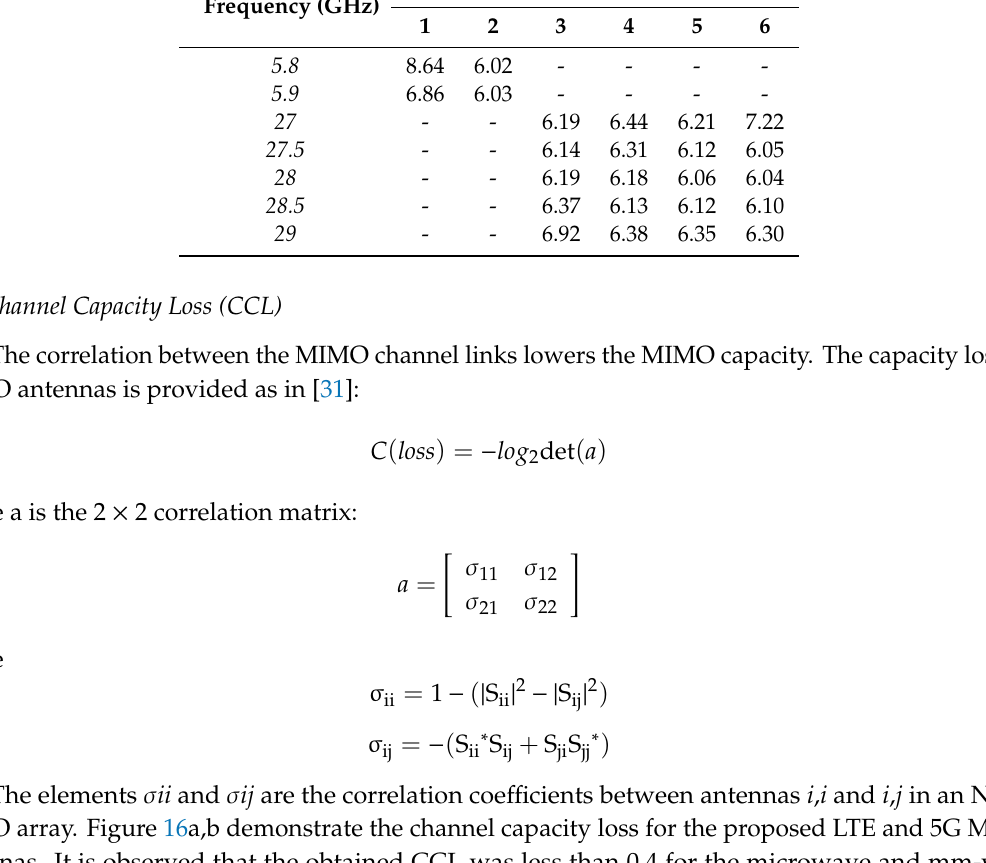
Table 4. Mean E ff ective Gain (MEG) for the Integrated Antenna Design. MEG ( − dB) of Ant Frequency (GHz)